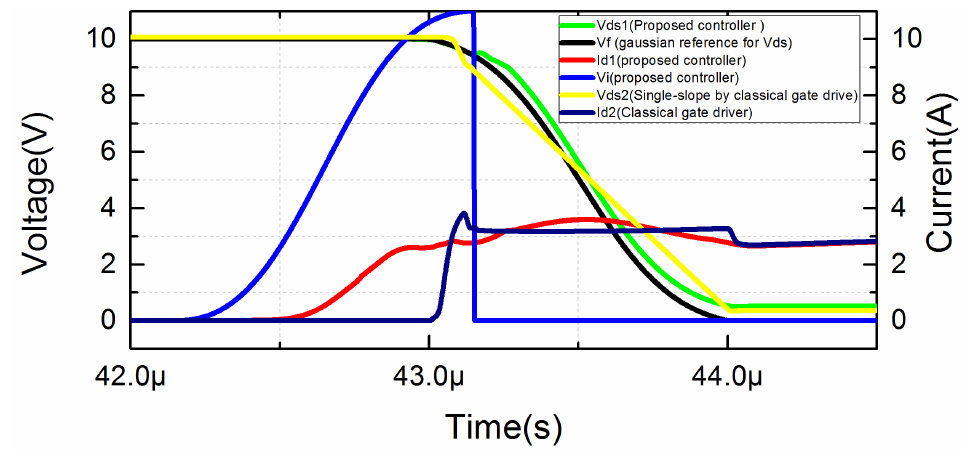
Figure 9. Pspice simulation for SiC MOSFET during turn-on with 1 µ s falling edge of V f (reference voltage) and 1 µ s rising edge of V i (the voltage to control current).